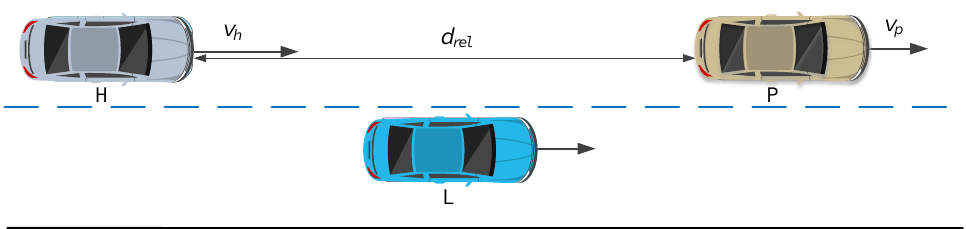
Figure 8. Sufficient relative distance.